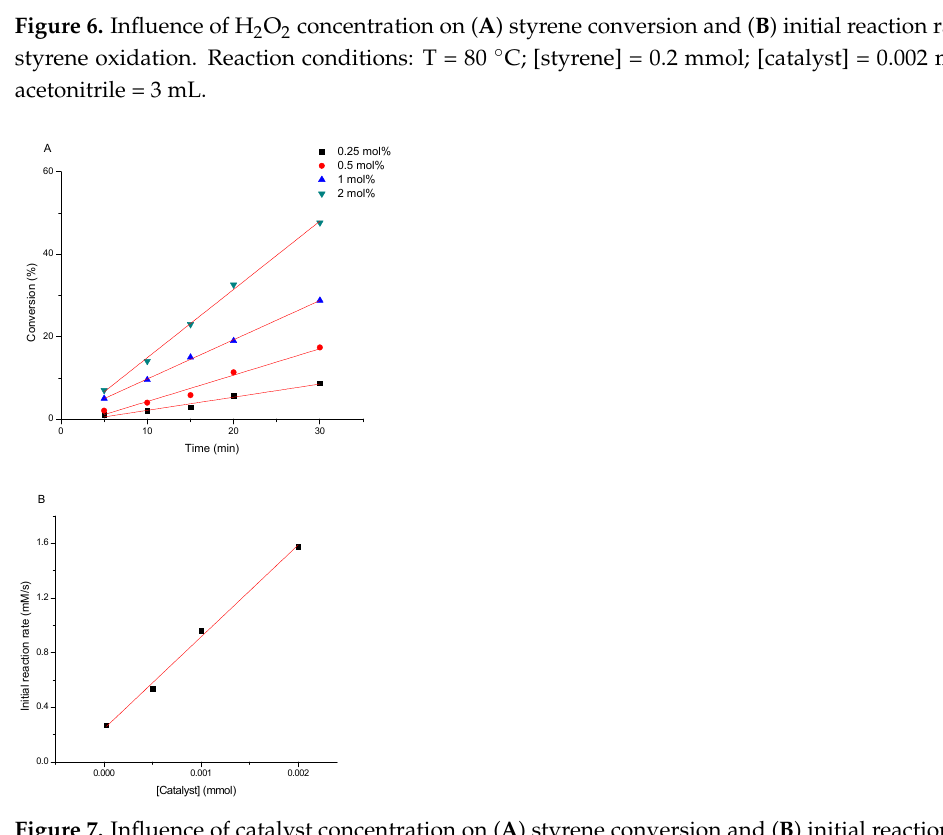
Figure 7. Influence of catalyst concentration on ( A ) styrene conversion and ( B ) initial reaction rate of styrene oxidation. Reaction conditions: T = 80 ◦ C; [styrene] = 0.2 mmol; [H 2 O 2 ] = 1.0 mmol; of styrene oxidation. Reaction conditions: T = 80 ℃ ; [styrene] = 0.2 mmol; [H 2 O 2 ] = 1.0 mmol; acetonitrile = 3 mL. acetonitrile = 3